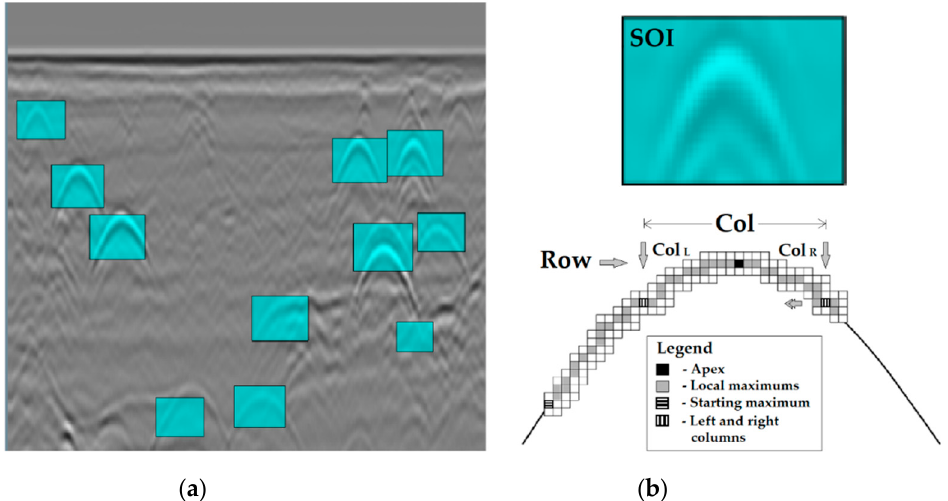
Figure 1. Initial steps of automated point extraction from radargrams (APEX) algorithm: ( a ) a trained cascade object detector (COD) picks out from a radargram the segments that might contain objects of interest; ( b ) analysis of each segment of interest (SOI) and hyperbola apex search.